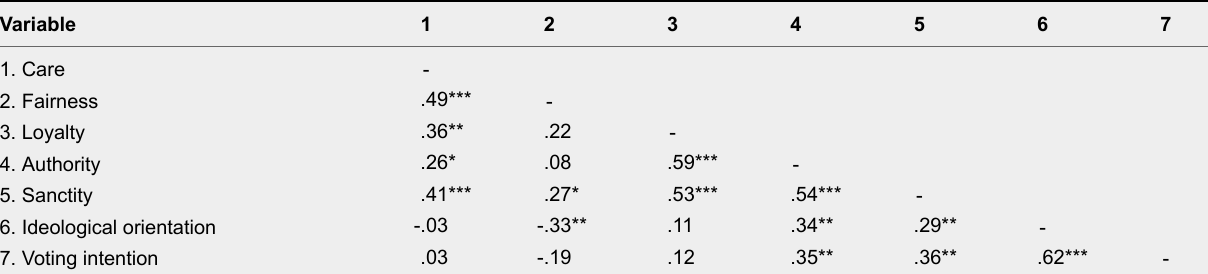
Note. Ideological orientation: from 1 = left-wing oriented to 5 = right-wing oriented. Voting intention coded as 0 = intention to vote for the challenging left-wing coalition; 1 = intention to vote for the incumbent right-wing coalition, Con Monti per